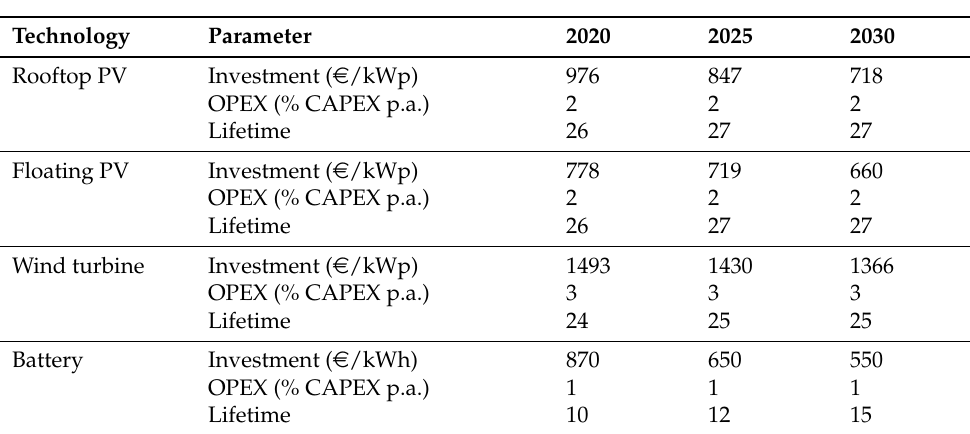
Table A2. Costs and lifetime of energy